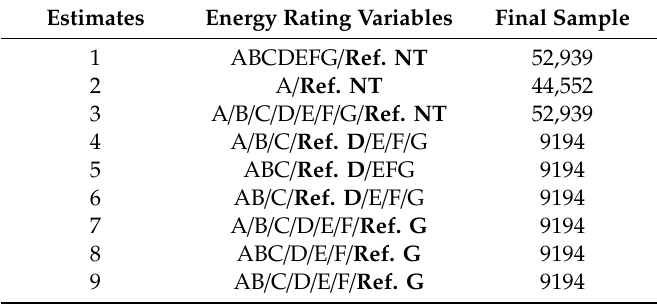
Table 3. Summary of estimates made based on the reference used, Ref.(qualification letter), and sample size.